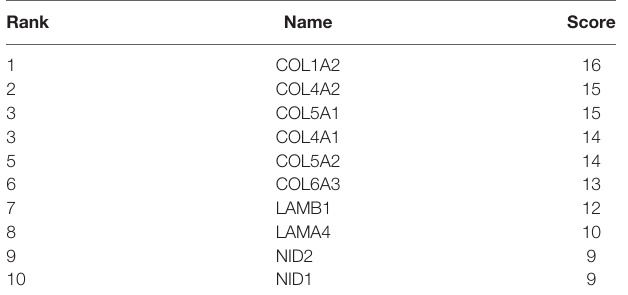
TABLE 2 | The ten hub genes obtained. TABLE 3 | Module